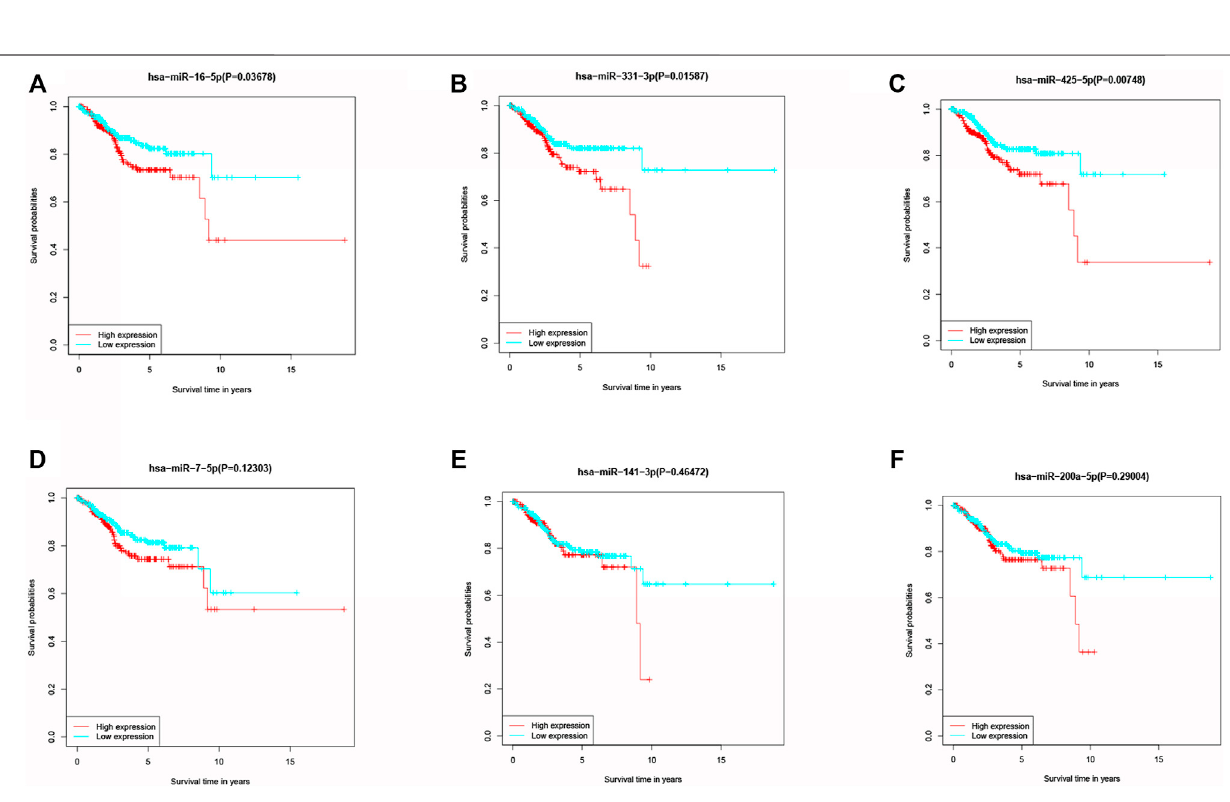
expression levels of miR-16-5p ( p = 0.03678, Figure 2A ), miR- 331-3p ( p = 0.01587, Figure 2B ) and miR-425-5p ( p = 0.00748, Figure 2C ) were all correlated with shorter survival time. In addition, there was no signi fi cant correlation between the